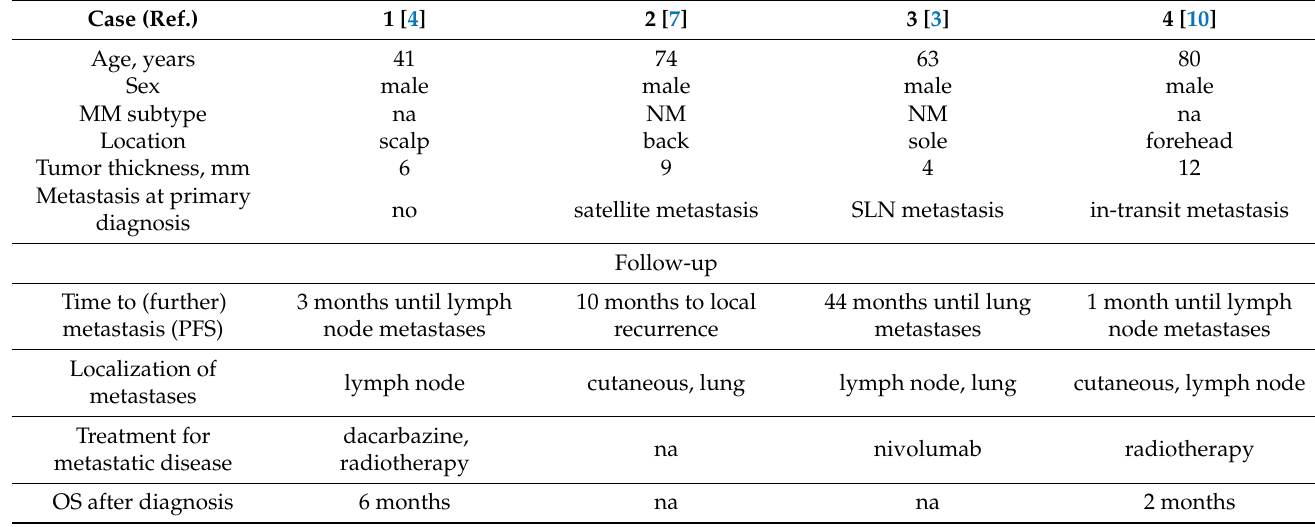
Table 2. Clinical characteristics of reported metastatic primary rhabdoid